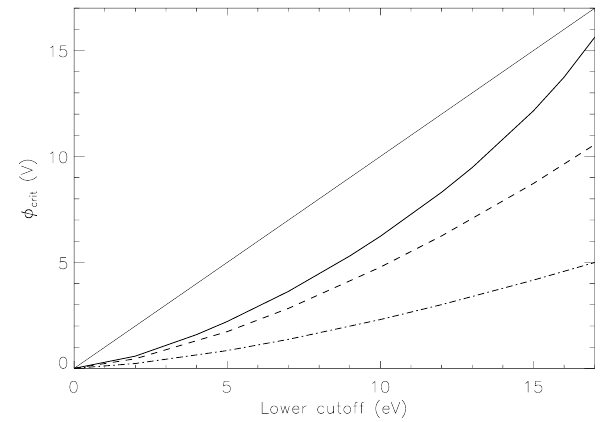
Fig. 7. Critical potential as a function of the lower cutoff of the √ − E > v l , in the detector, in the solar wind case (solid line), the magnetosheath case (dashed line) and the magnetosphere case (dot-dashed